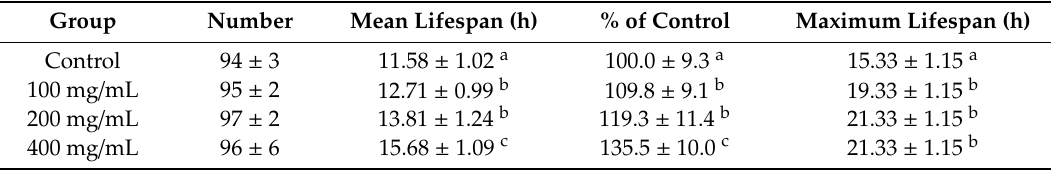
Values with di ff erent letters in the same column indicate statistical significance ( p < 0.05). Table 3. E ff ect of orange extracts on UV-B irradiation of N2 wild-type C. elegans (mean ± SD, n = 3). Group Number